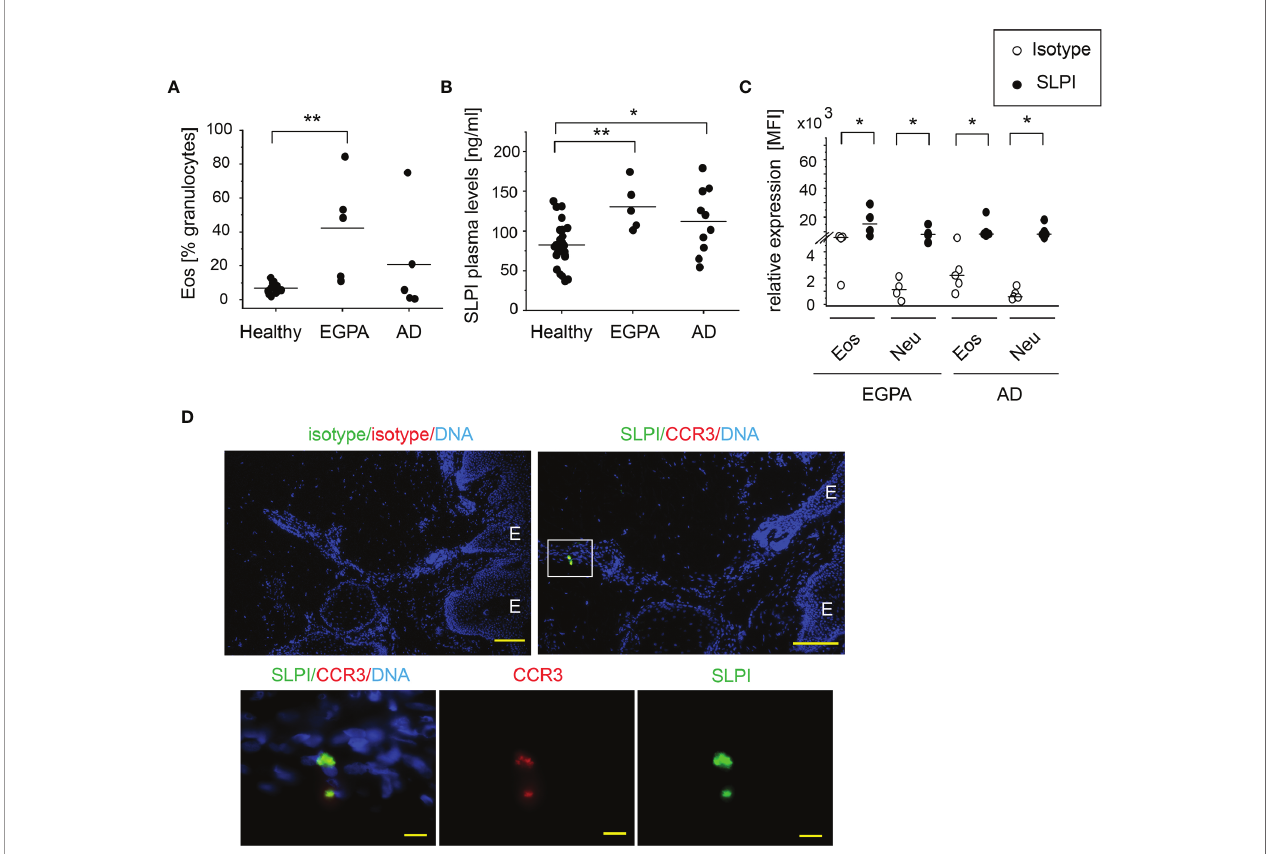
FIGURE 2 | Patients with blood eosinophilia demonstrate high levels of SLPI in plasma and SLPI-immunoreactive granulocytes. The donors indicated were subjected to isolation of granulocytes, plasma, and/or skin biopsies. Dots indicate individual donors and lines the mean or median value for each data set. (A) % of eosinophils among granulocytes was determined using fl ow cytometry. Lines indicate the mean, n = 5 – 13, **p < 0.001; ANOVA, Tukey post hoc . (B) SLPI levels in plasma were quanti fi ed using ELISA. Lines indicate the mean, n = 5 – 26, **p < 0.01; *p < 0.05; Tukey ANOVA. (C) Levels of SLPI were determined using fl ow cytometry. Lines indicate the median, n = 4 – 5, *p < 0.05; Mann – Whitney test. (D) Fluorescence microscopy images of affected skin of AD patient. Skin was stained for SLPI or isotype control (green), CCR3 to detect eosinophils, or isotype control (red) with Hoechst counterstain to detect DNA (blue). An overlay and single- channel images from one donor. Data are representative for 3 donors. E indicates epidermis. Scale bar = 50 m m, or 10 m m (enlarged